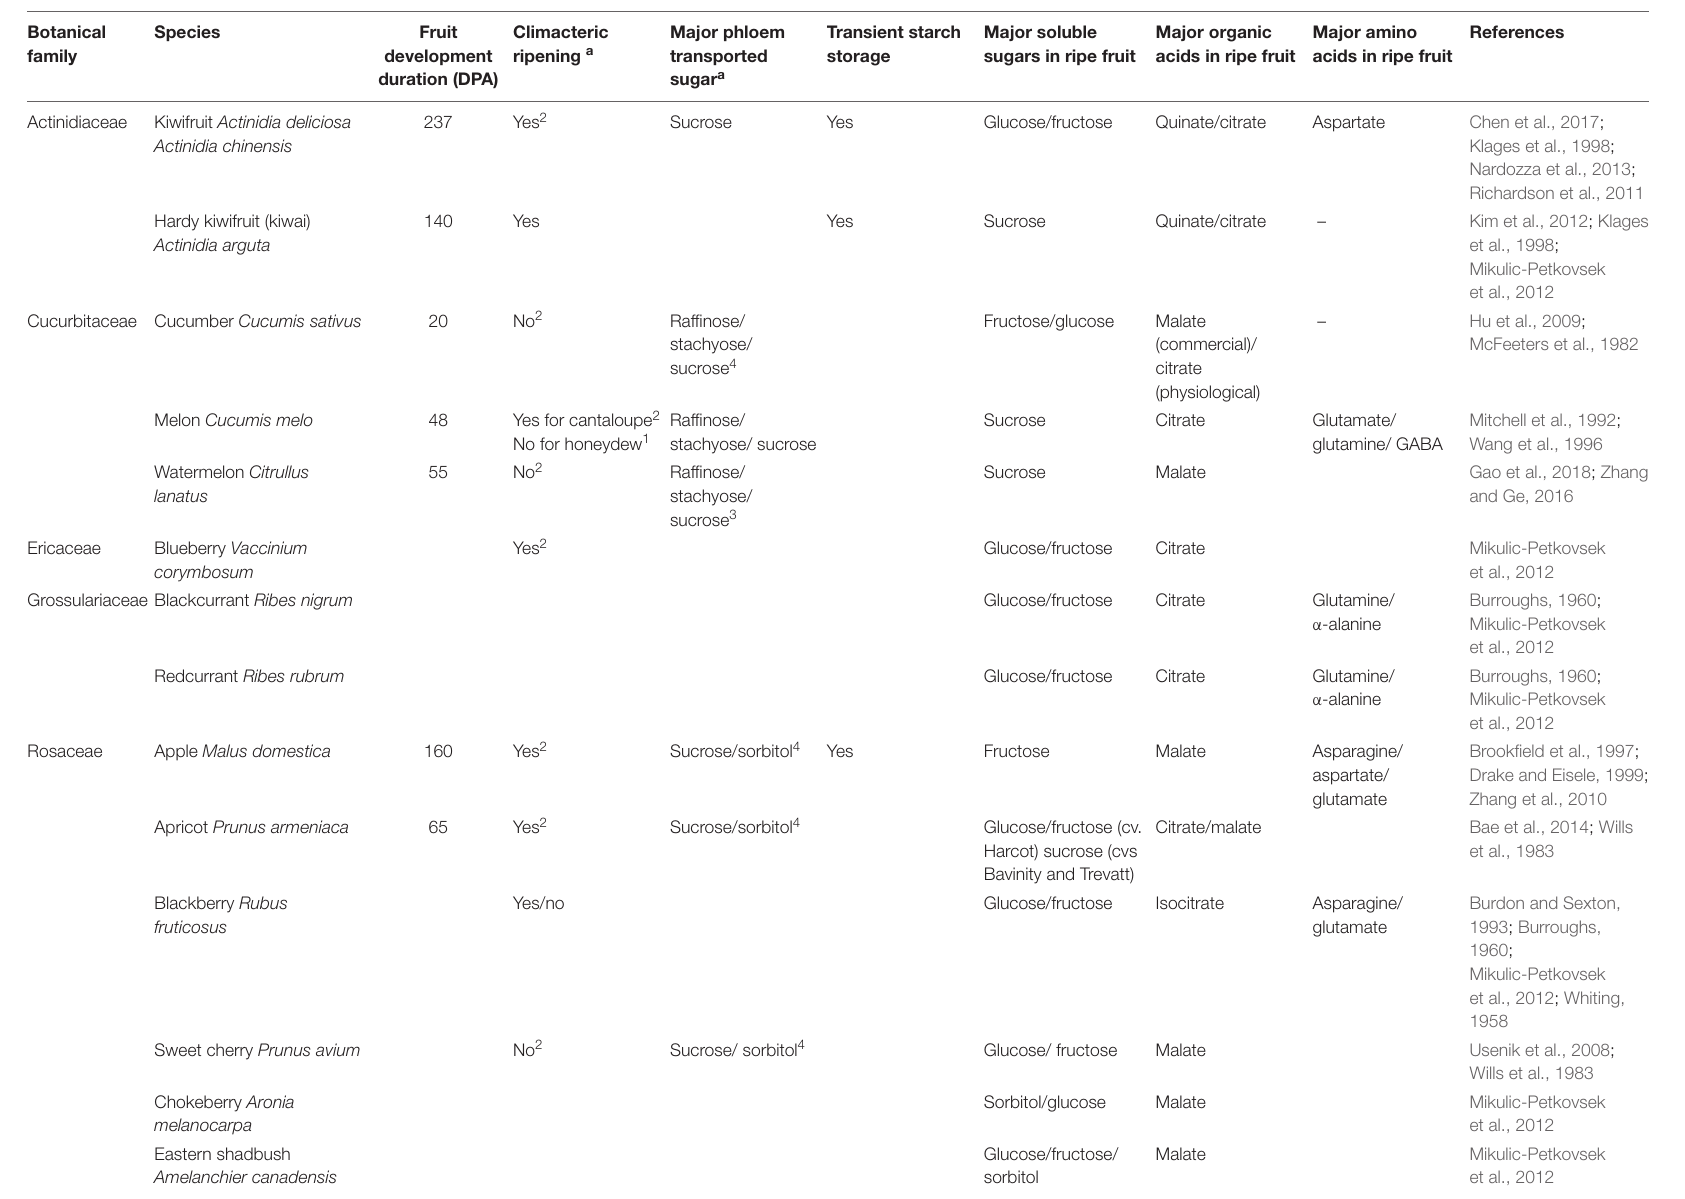
TABLE 1 | Major characters linked with primary metabolism and differing between temperate fruit species. Botanical